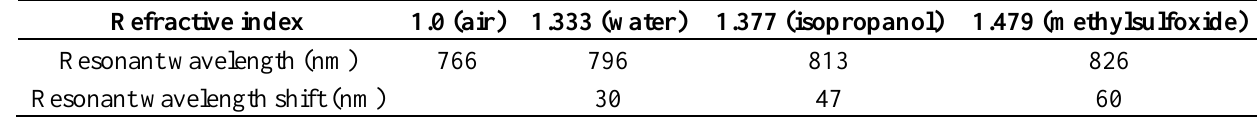
Table 3. Resonant wavelength of different samples with TM